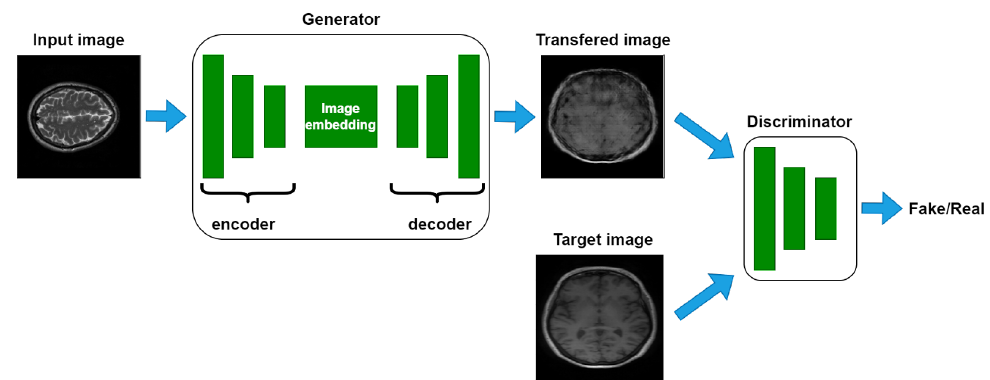
Figure 1. Overall flowchart of image-to-image transmission with Pix2Pix GAN.